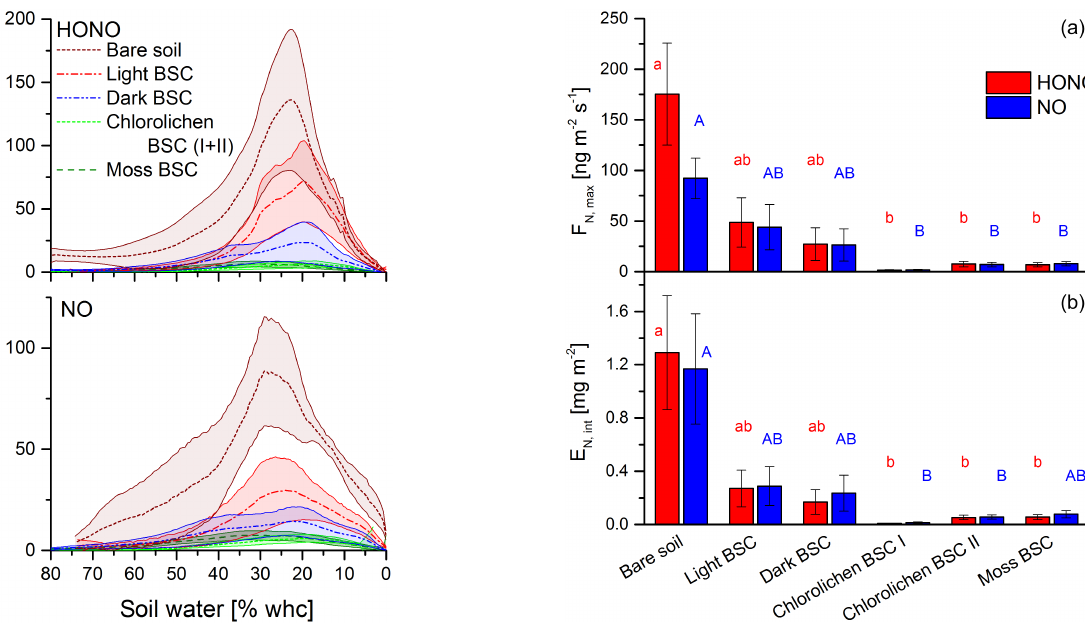
Figure 4. HONO and NO emission fluxes as a function of soil water content. Dotted lines are the mean fluxes. Shaded areas indicate the standard deviation.